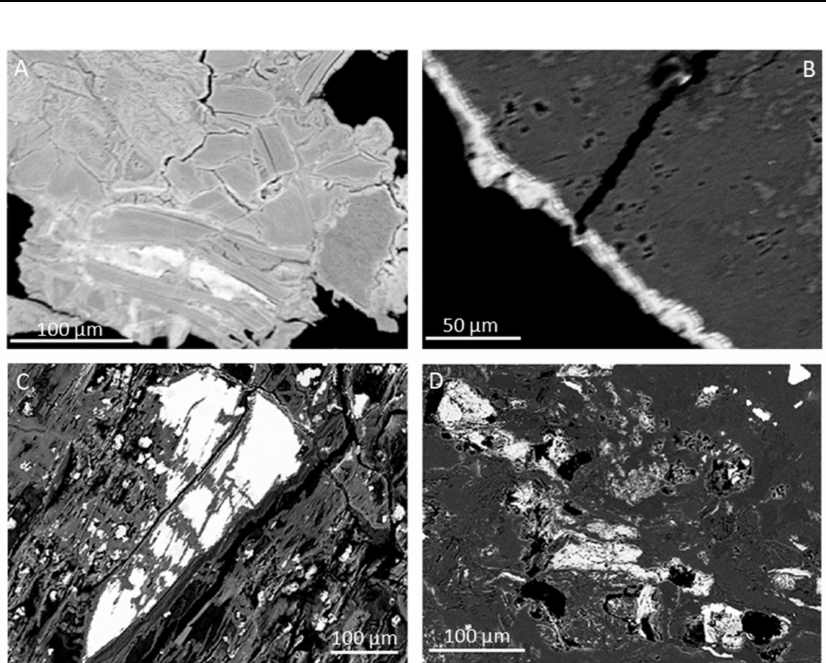
Figure 10. BSE images of the four main textures of Mn oxy-hydroxide grains within the Piau í profile, as described in the text. ( A – C ) are from SAPMG and ( D ) is form